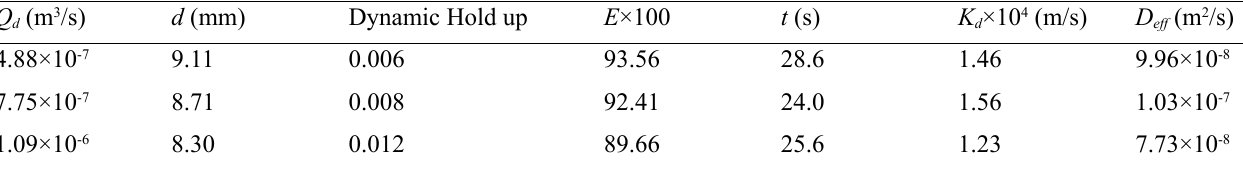
Table 3. Experimental data for mass transfer coefficients at the absence of nanoparticles. Q (m 3 /s) d (mm) Dynamic Hold up d